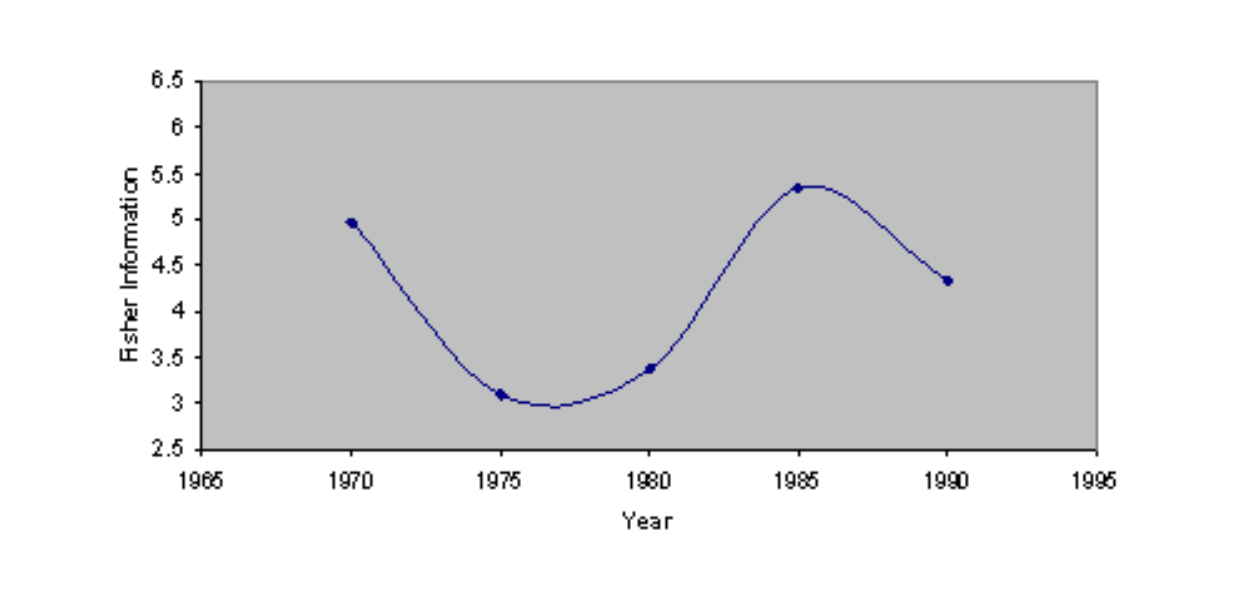
Fig. 4. Fisher information: biological